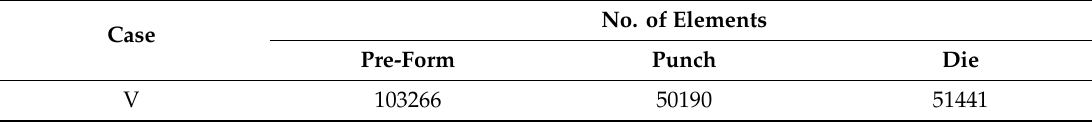
Table 2. Details of discretization.